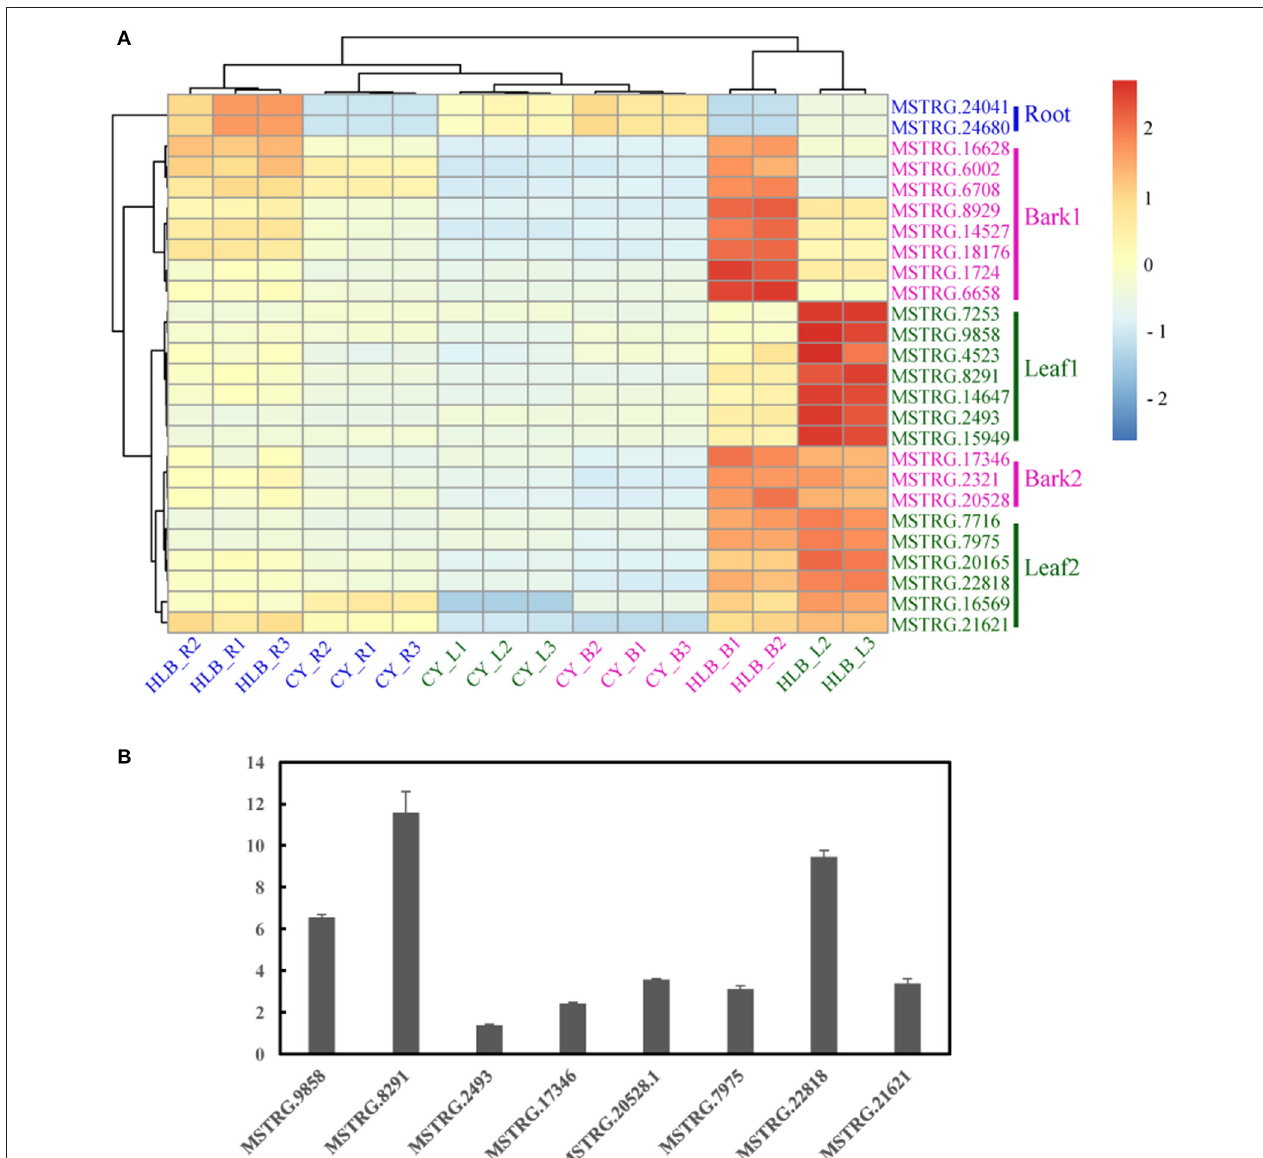
FIGURE 8 | Heatmap of 26 putative marker genes in the three tissues (A) and quantitative reverse transcription (qRT)-polymerase chain reaction (PCR) verification of several putative marker genes in the leaves. (B) The expression level of the putative marker gene in healthy leaves was set as 1 in the qRT-PCR analysis.